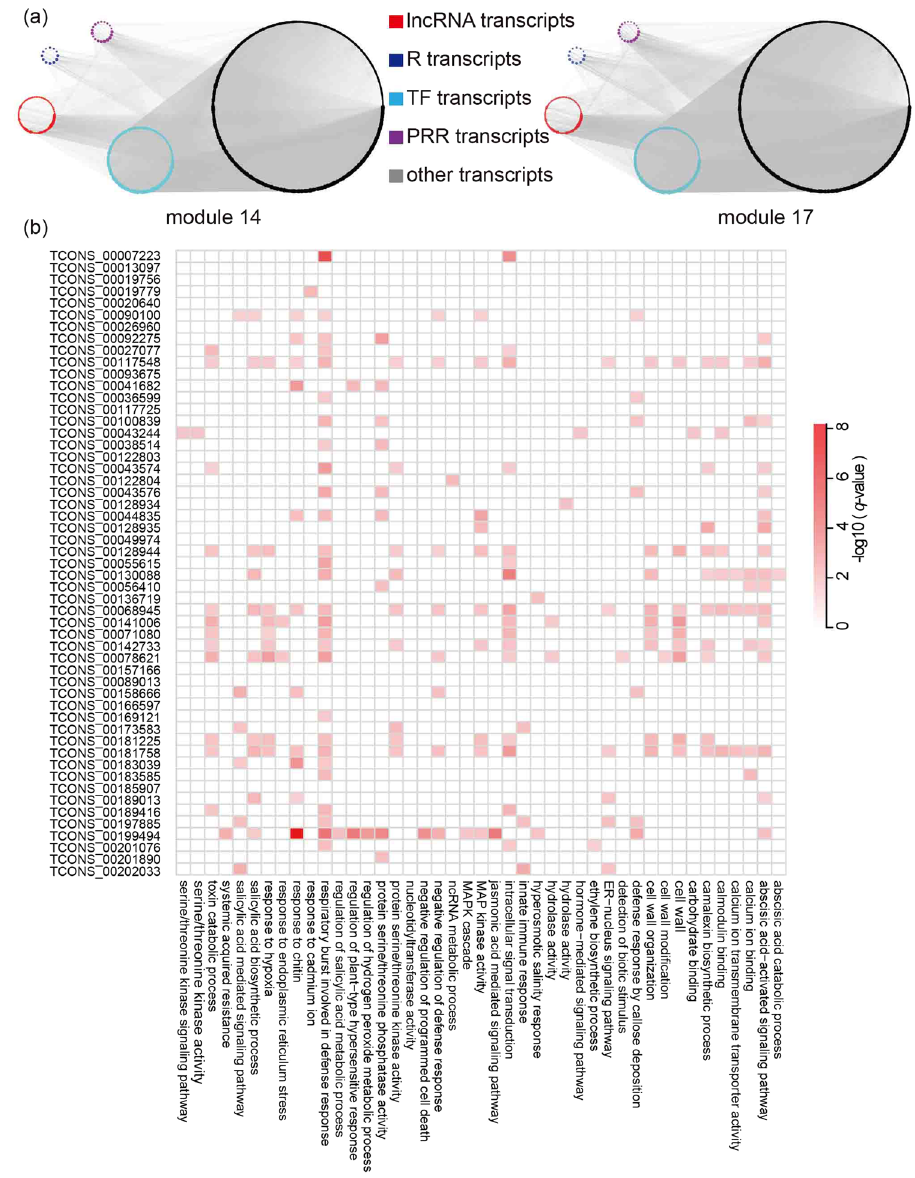
Figure 7. Network visualization of WGCNA modules and GO enrichments of genes associated with lncRNAs. ( a ) Network of module 14 and 17 on the basis of WGCNA analysis. ( b ) GO enrichment analysis of genes associated with lncRNAs within module